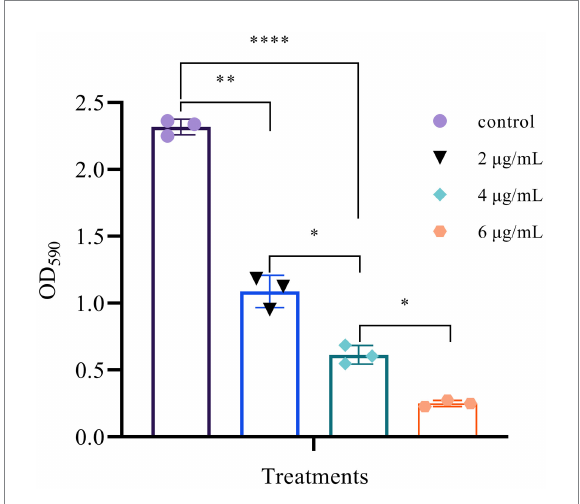
FIGURE 9 Suppression of biofilm formation of different concentrations of AgNPs. Error bars represent standard deviation from the mean of three replicate values (ns non statistically significant difference, * p <0.05, ** p <0.01, **** p